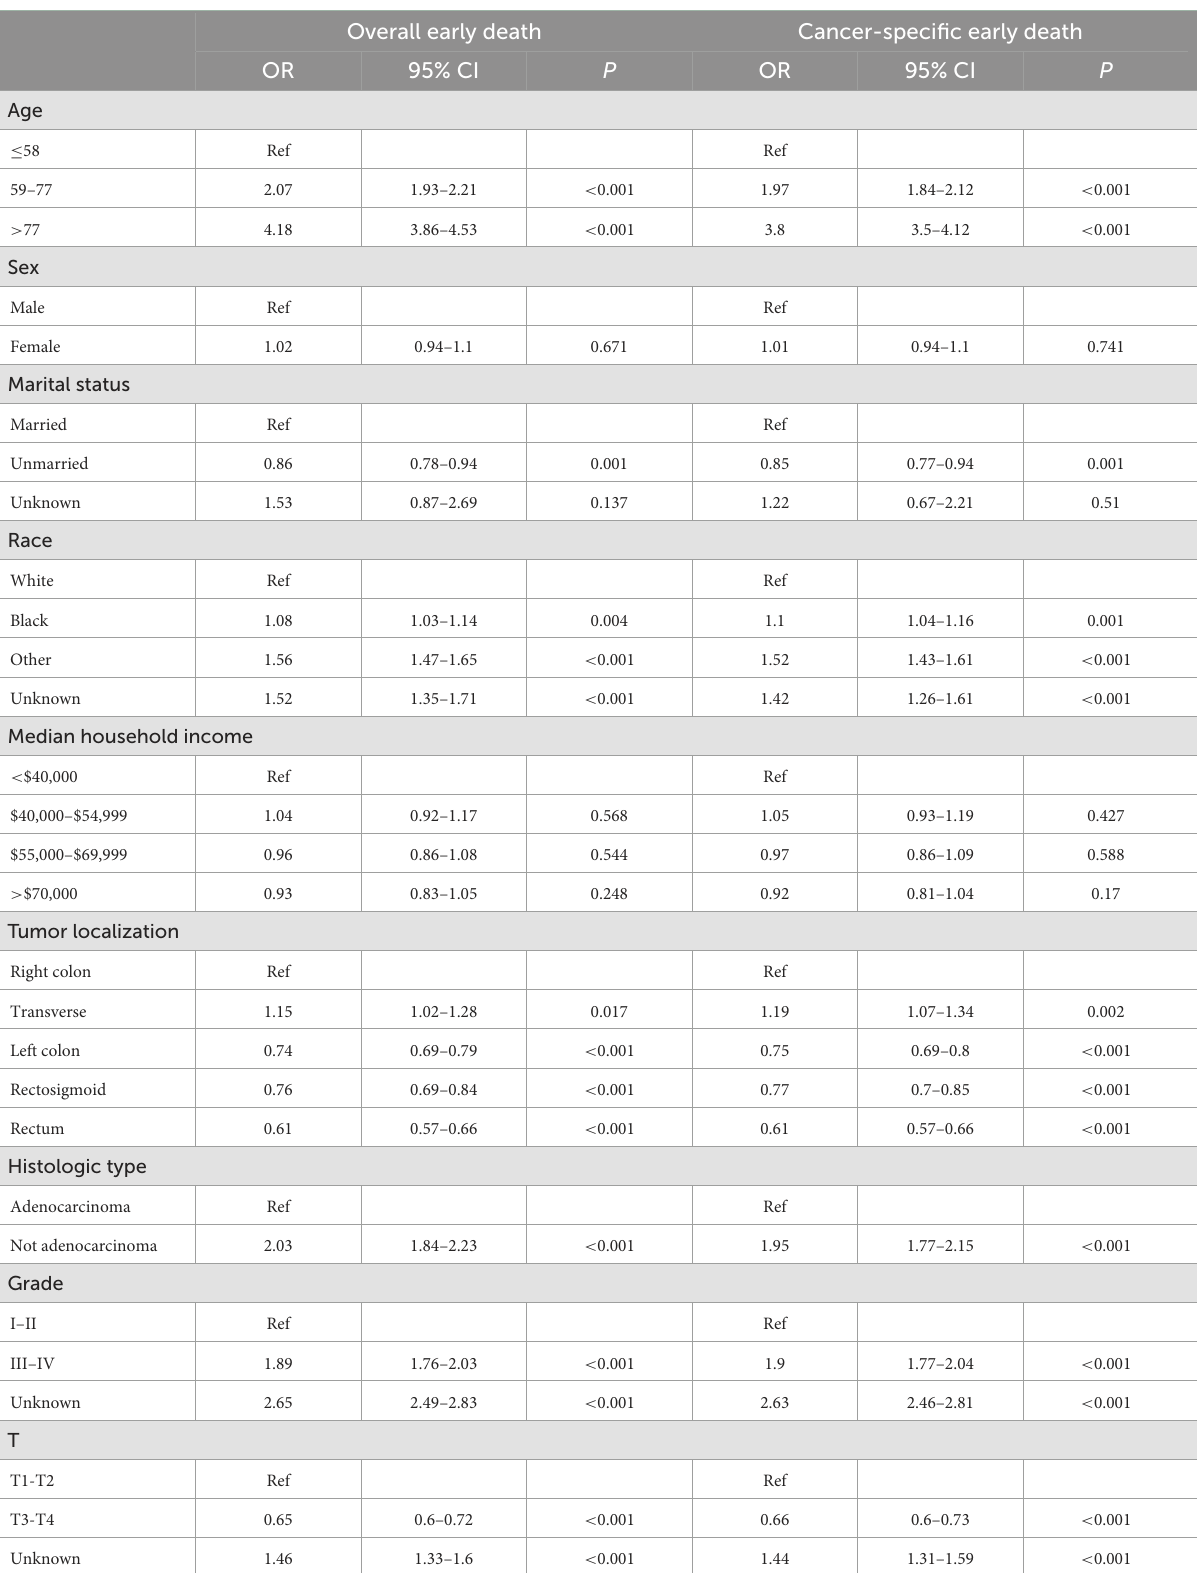
TABLE 3 Univariate logistic analysis of overall early death and cancer-specific early death in patients with